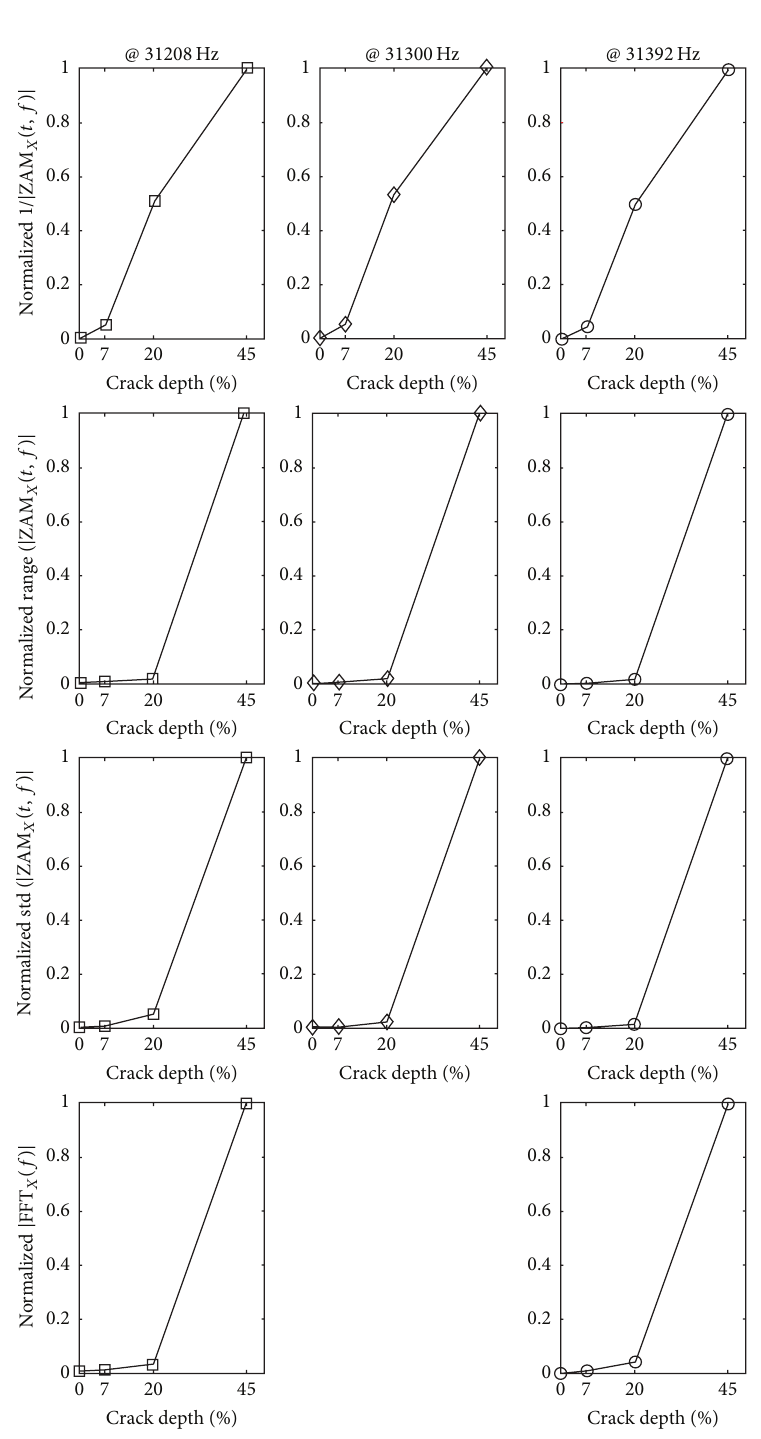
Figure 7: The separate damage indices (sDI) based on the 1/| ZAM 𝑋 (𝑡,𝑓)| (first row), the MAX-MIN range (second row), the corresponding standard deviation (third row) of the ZAM transform, and the normalized FFT magnitude (fourth row) at the corresponding VAM frequencies, that is, 31208 Hz (left column), 31300 Hz (middle column), and 31392 Hz (right column), respectively. Note that, for the FFT- based analysis, only the 31208 Hz (left column) and 31392 Hz (right column) were considered, since the FFT amplitude at the central high- frequency (31300 Hz) was used as a normalization factor. Moreover, in the ZAM-based analysis, all values were estimated for the time span of 0.006–0.036 sec to avoid edge effects, while all data samples acquired (92001) were used in the FFT-based analysis to increase its frequency